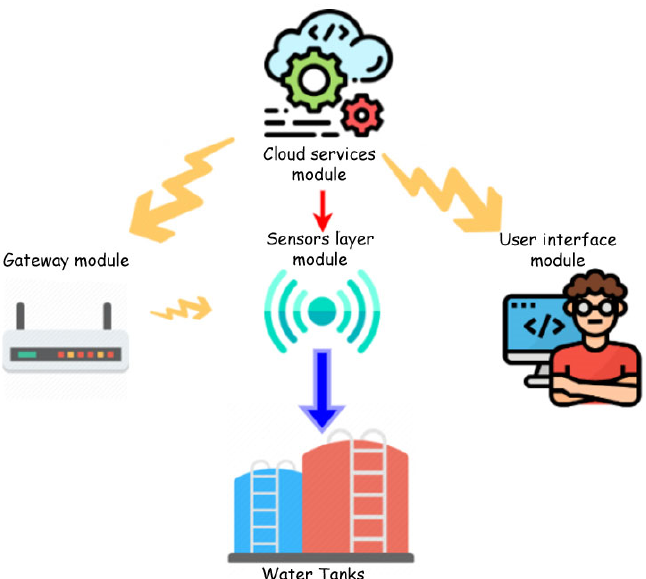
Figure 6. Automatic Quality Control for Water.